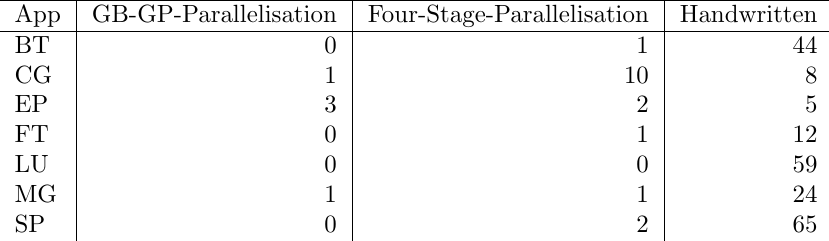
Table 2: The number of FOR loop structures parallelised (for nested loops, only the outermost parallelised loop is